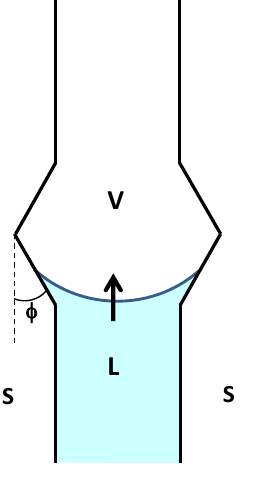
Figure 14. Infiltration in a pore locally exhibiting an increase in pore area perpendicular to the infiltration